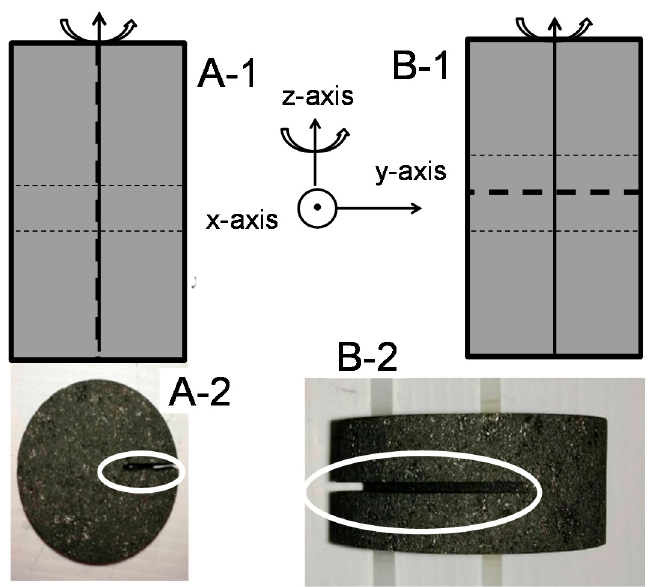
Figure 5. Schematic view of the cuts performed on sliced samples, along the revolution axis ( z -axis) ( A - 1 , A - 2 ) and normal to the revolution axis ( B - 1 , B - 2 ).